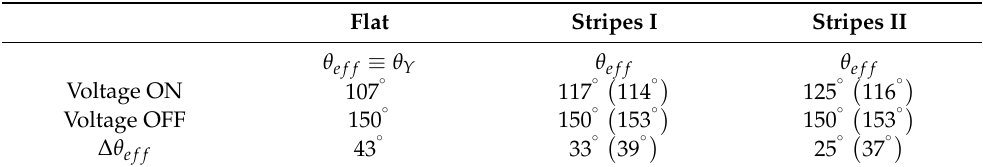
Table 1. Effective contact angles at the two wetting states (voltage ON and OFF) and contact angle modification, for the flat and the two micro-structured surfaces. The effective contact angles are computed using third order polynomial fitting and the Cassie–Baxter relation (the values inside parentheses).